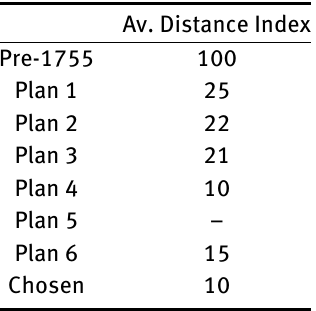
Table 1: Average distance (base 100 = Pre-1755) of the mobility anal- ysis between Rossio and Terreiro do